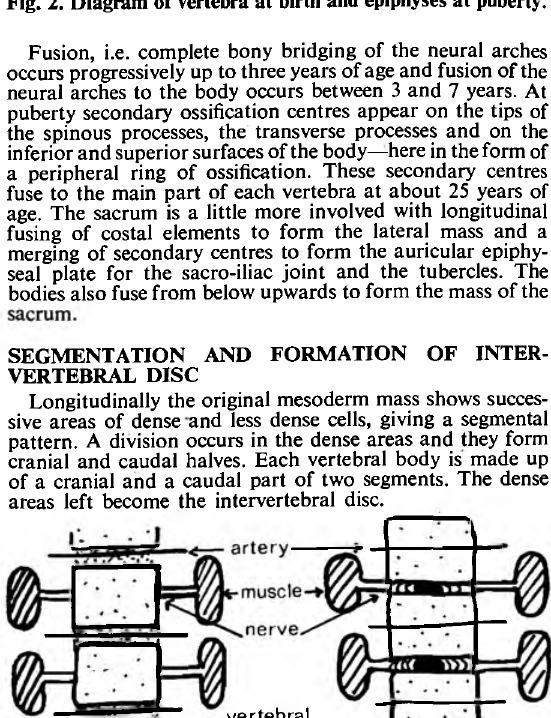
Fig. 3. Diagram of formation of vertebral body from original mesoderm